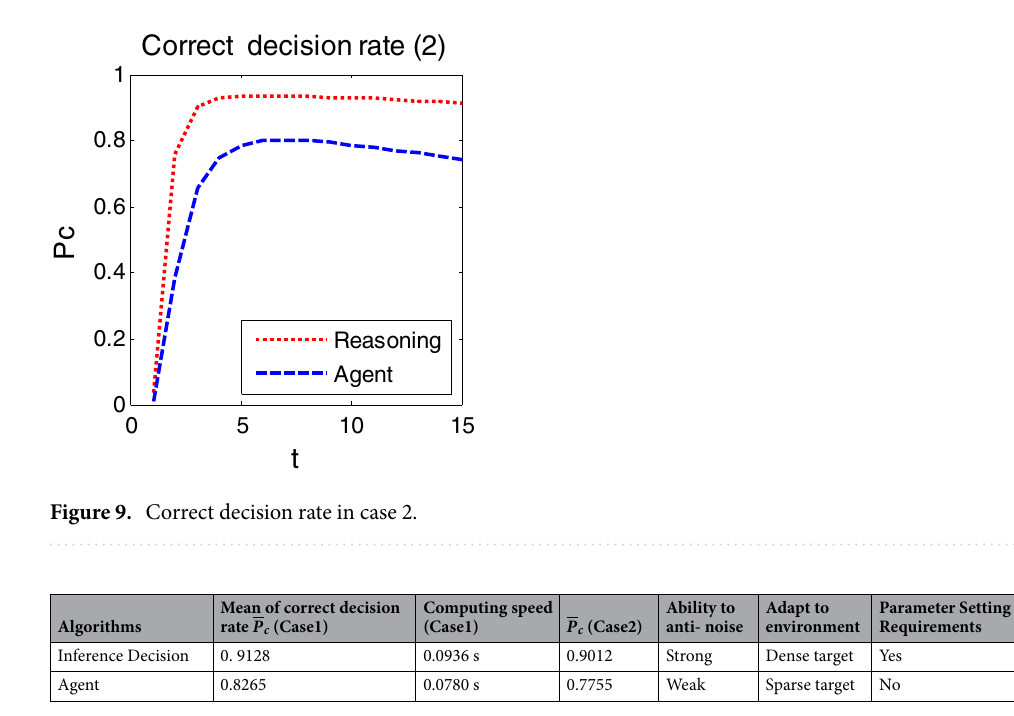
Table 2. Comprehensive comparison between inference decision method and Agent